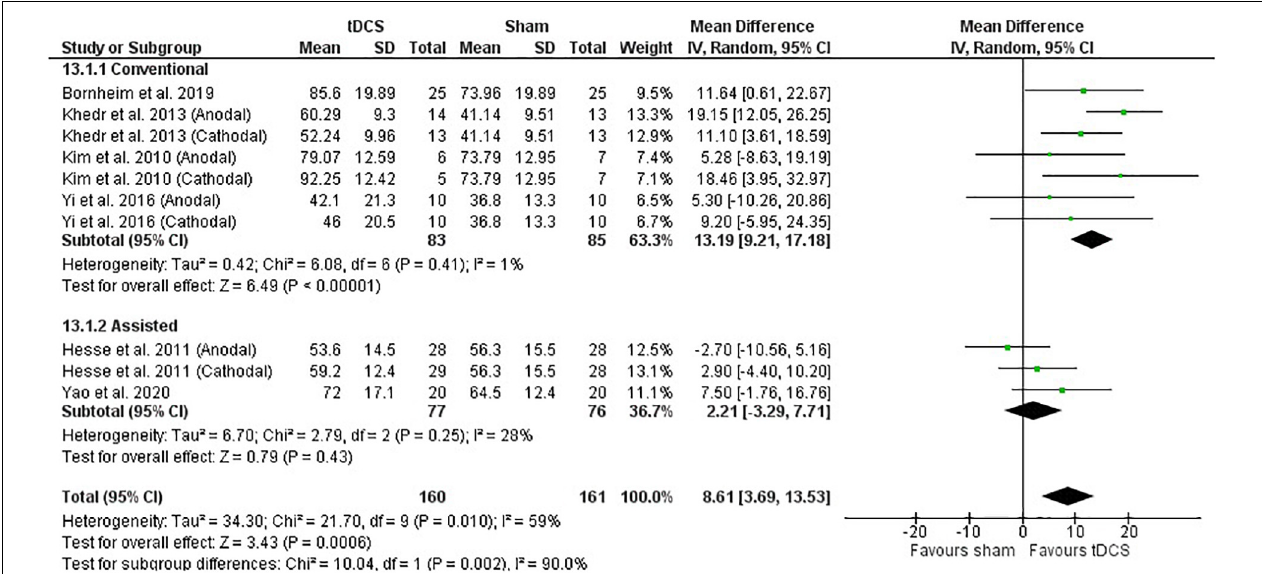
FIGURE 6 | Effects of therapy (conventional and assisted) combined with tDCS on stroke recovery as assessed by the post-intervention data of the tDCS and sham groups for the Barthel Index.